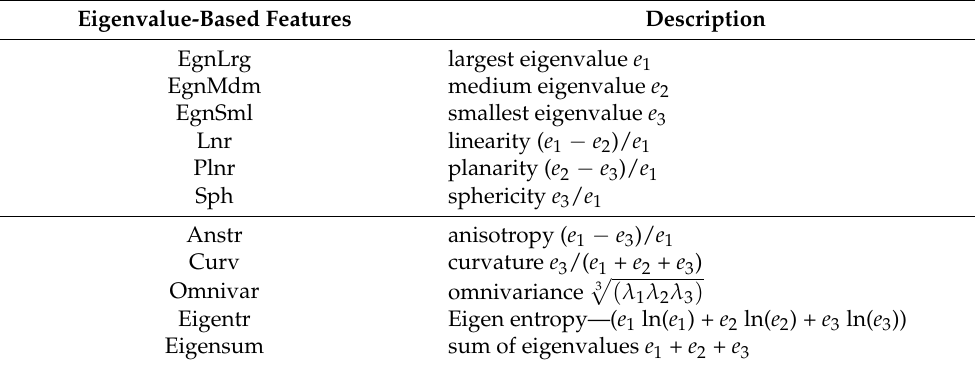
Table 3. Overview of the eigenvalue-based features. Eigenvalue-Based Features